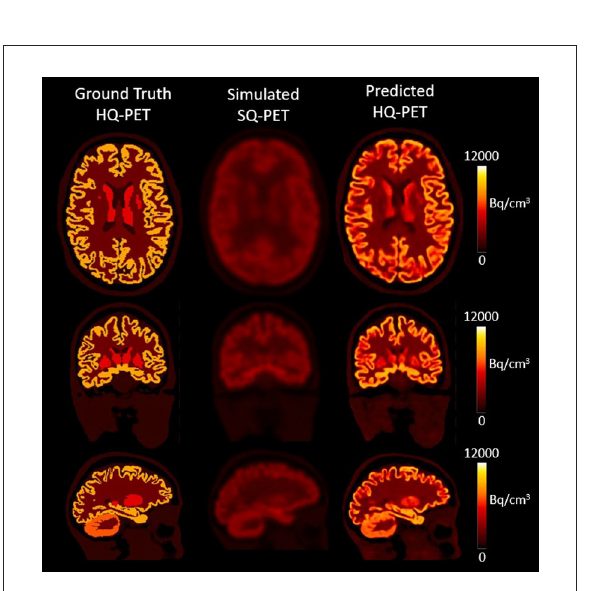
FIGURE2 Results from one subject belonging to the test dataset. The first column depicts the Ground Truth High Quality (HQ) PET, the second column the corresponding simulated Standard Quality (SQ) PET and the third column the Predicted HQ PET, i.e., the output from the proposed network. For each set, from top to bottom, transverse, coronal, and sagittal slices are shown. Images are displayed using radiological conventions (subject’s left on the right). Bq, Becquerel.